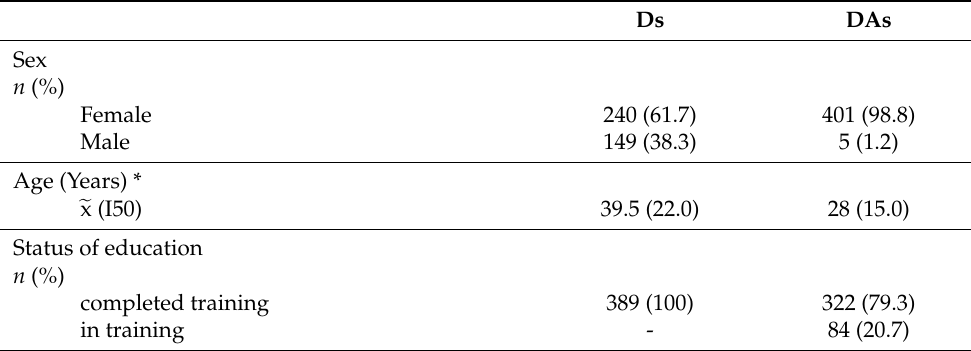
Table 1. Individual data of the study population: Ds and DAs.